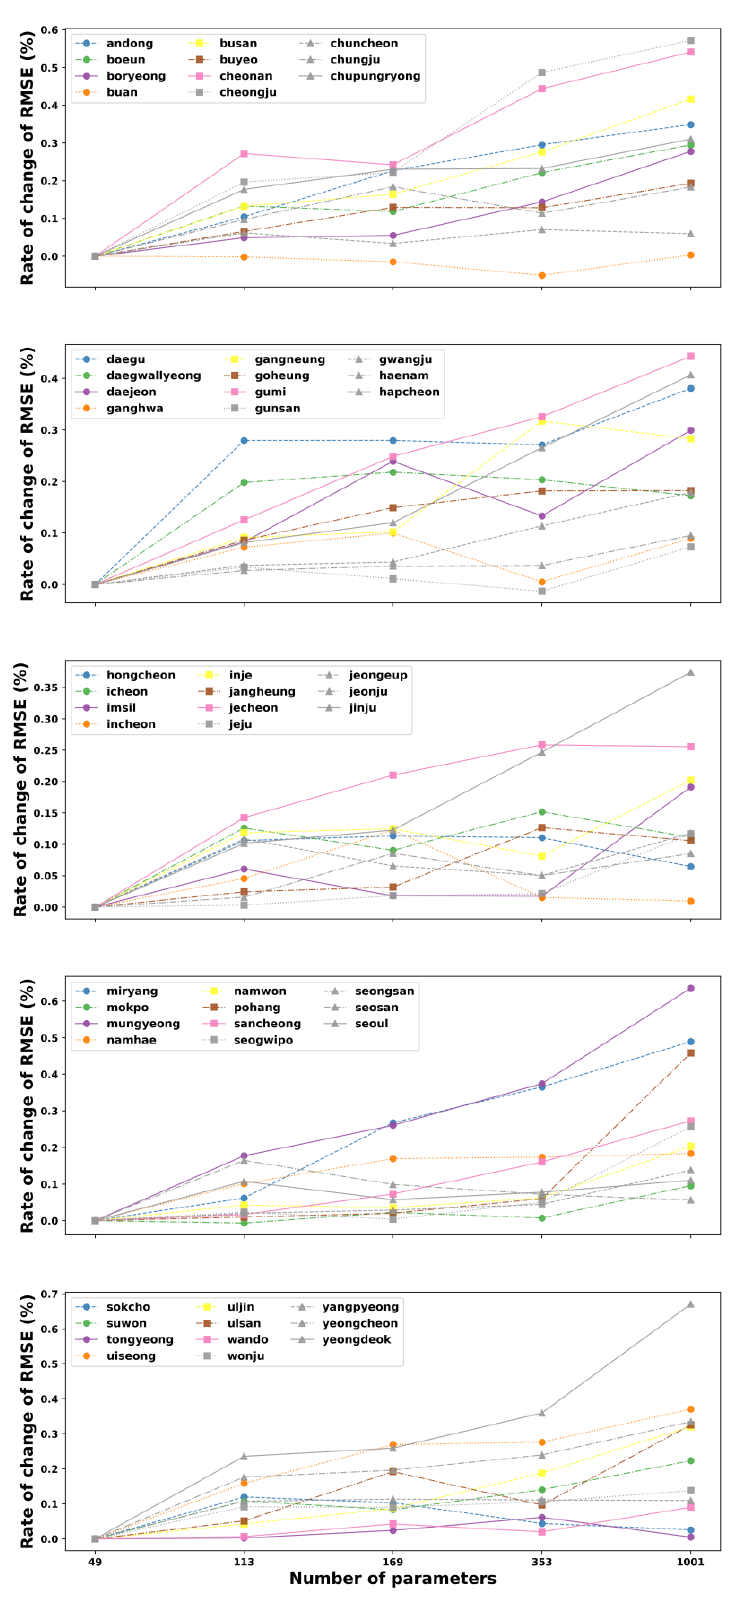
Figure 5. The rate of change of the mean RMSE of the 5-hidden layer ANN corresponding to 49, 113, 169, 353, and 1001 trainable parameters for the test data for all 55 stations in South Korea.